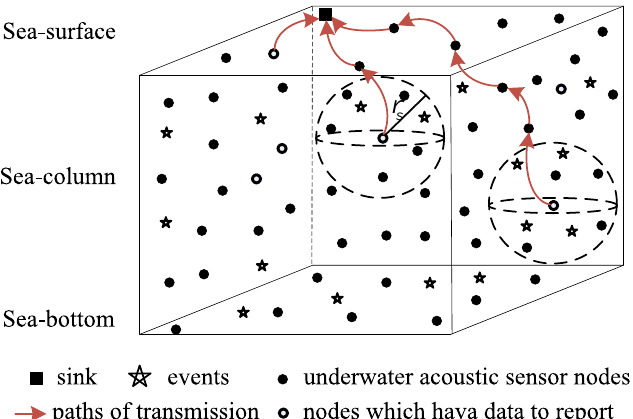
Figure 1. Three-dimensional underwater acoustic sensor network